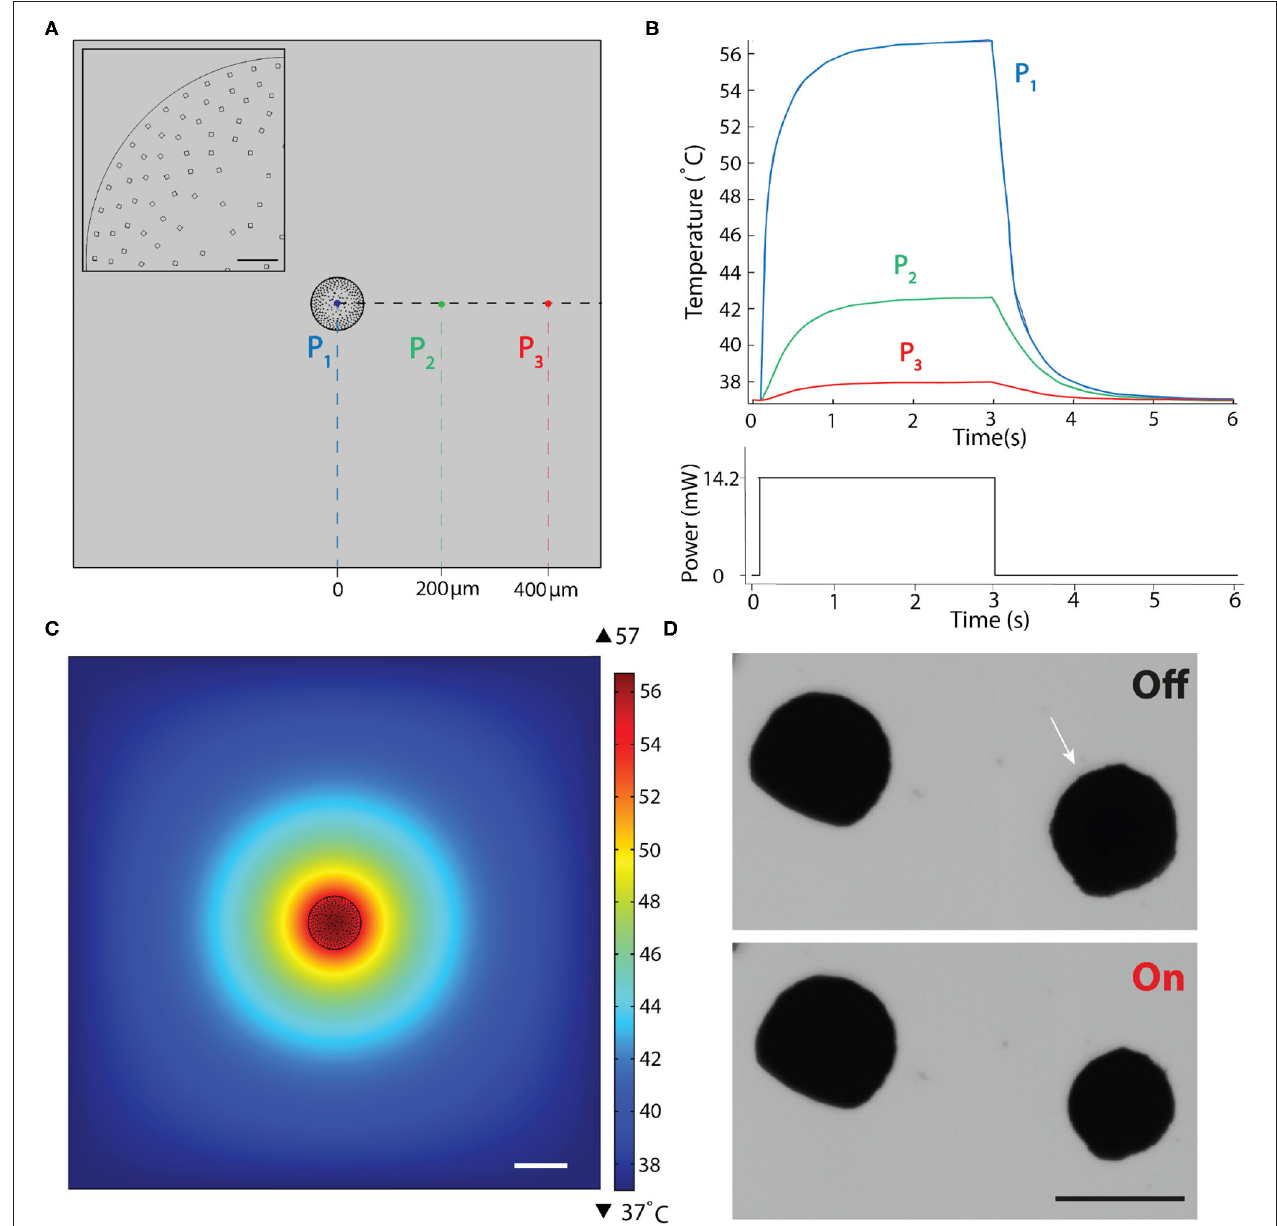
FIGURE 3 | Finite element simulations of the heat transfer during actuation. (A) 2D drawing showing the boundary conditions. Inset is a close-up view of the actuator highlighting the nanoheater elements. Scale bar, 10 µ m. (B) Temperature changes over a complete actuation cycle at the three different points shown in (A) . The input excitation signal is shown on the bottom plot. (C) Temperature as a function of distance from the µ OMA irradiated at 14.2 mW laser power at the steady state. Scale bar, 100 µ m. (D) Selective actuation of a µ OMA (denoted with the white arrow) at 14.2 mW laser power in close proximity of another µ OMA. Bottom image shows that only the illuminated actuator responds to the signal. Scale bar, 100 µ